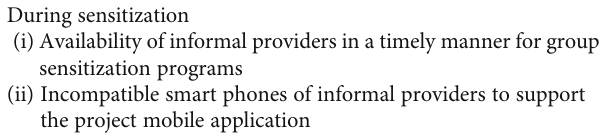
Table 3: Key challenges encountered by the RIPENED project sta ff . During sensitization